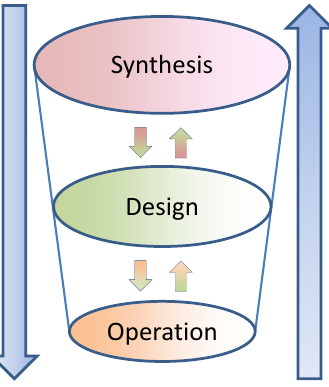
Figure 1. The three interrelated levels of optimization.